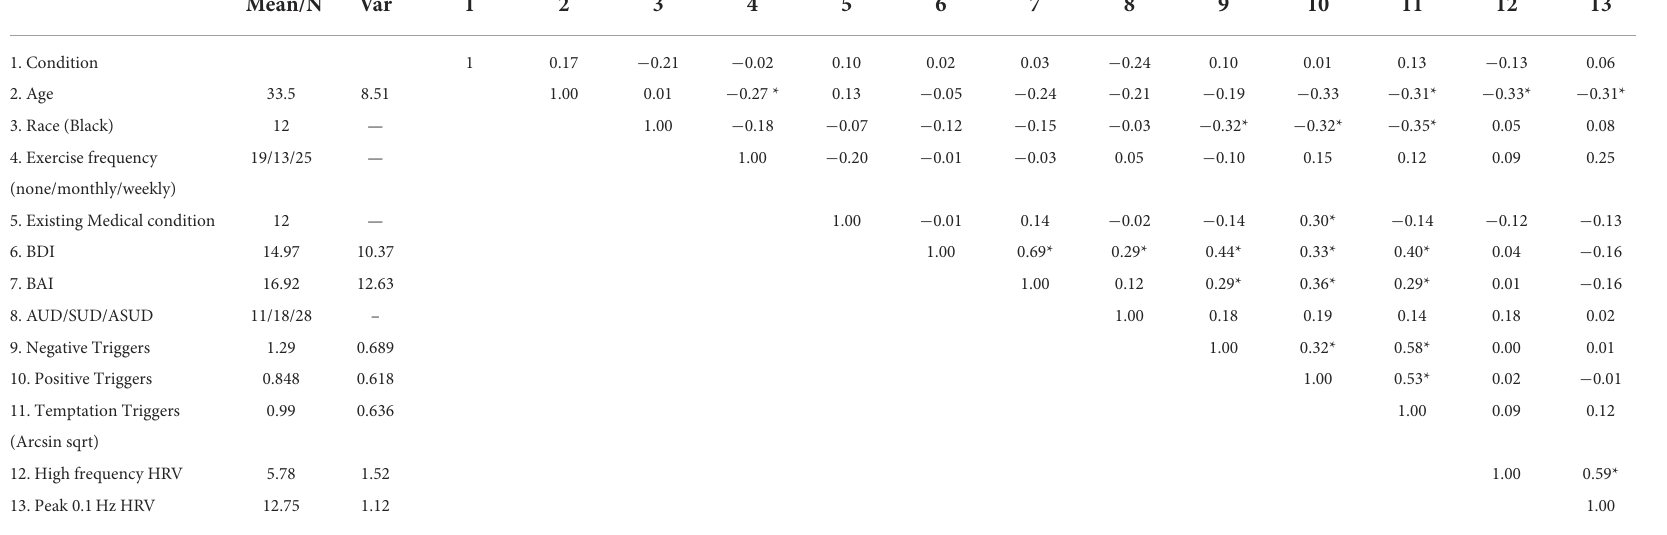
TABLE 2 Demographics and bivariate correlation